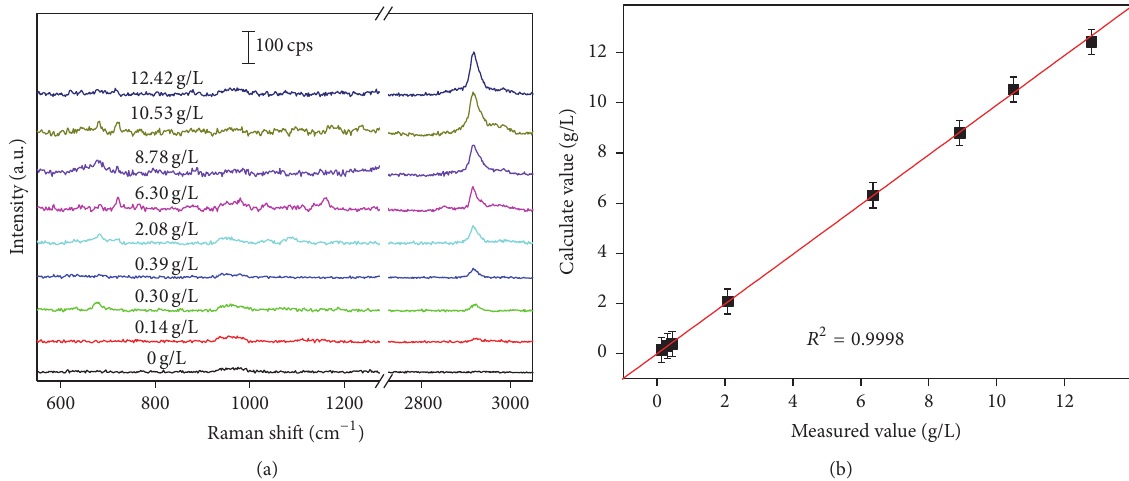
Figure 4: SERS spectra of SAM solution in different concentration (a). Plot for the comparison of the measured value with the calculated value (b). Each sample was measured for 5 times and the average was calculated. The SAM solution of 0g/L was used to prove that the peak centered at ∼ 2920 cm −1 was produced by SAM.